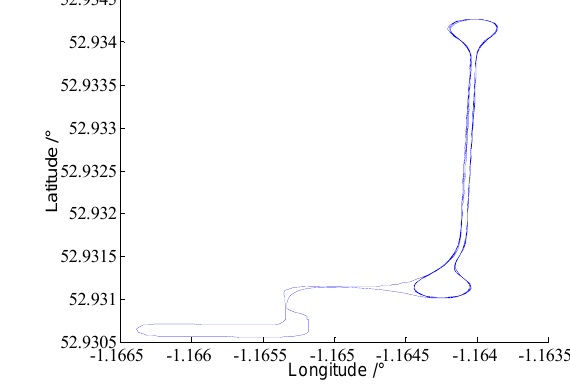
Figure 5. The vehicle trajectory of case 2